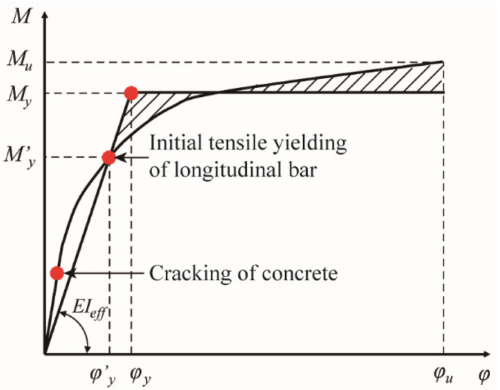
Figure 15. Equivalent yielding moment and curvature.